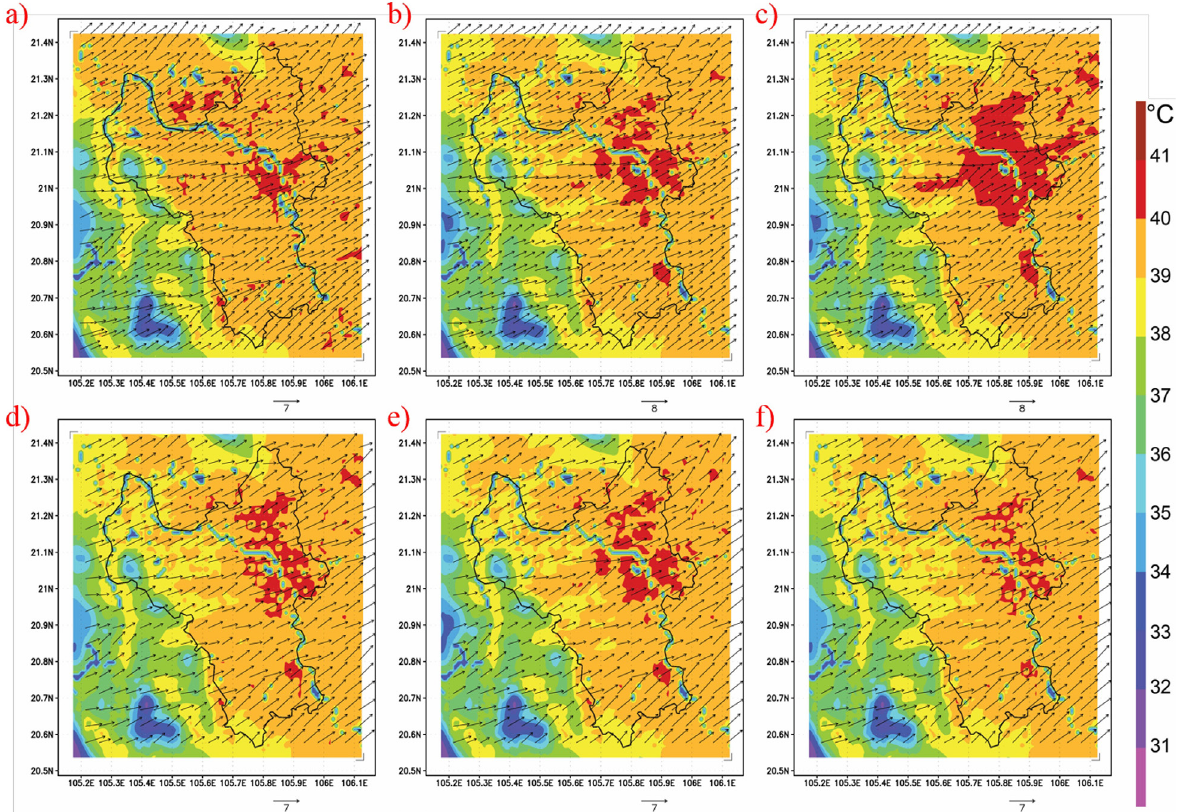
Figure 6. Air temperature and wind distribution at 16:00 on 17 June for ( a ) U_CUR; ( b ) U_HMP; ( c ) U_NOGREEN; ( d ) U_PARK; ( e ) U_HMPFOREST; ( f )